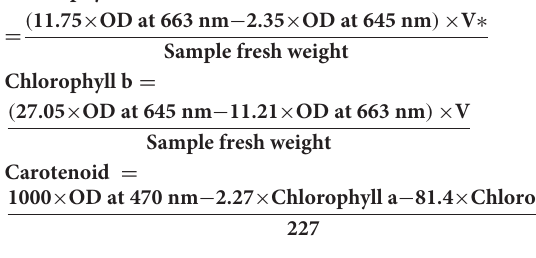
hours using a portable fluorometer (FluorPen FP110, Photon Systems Instruments, Drásov, Czech